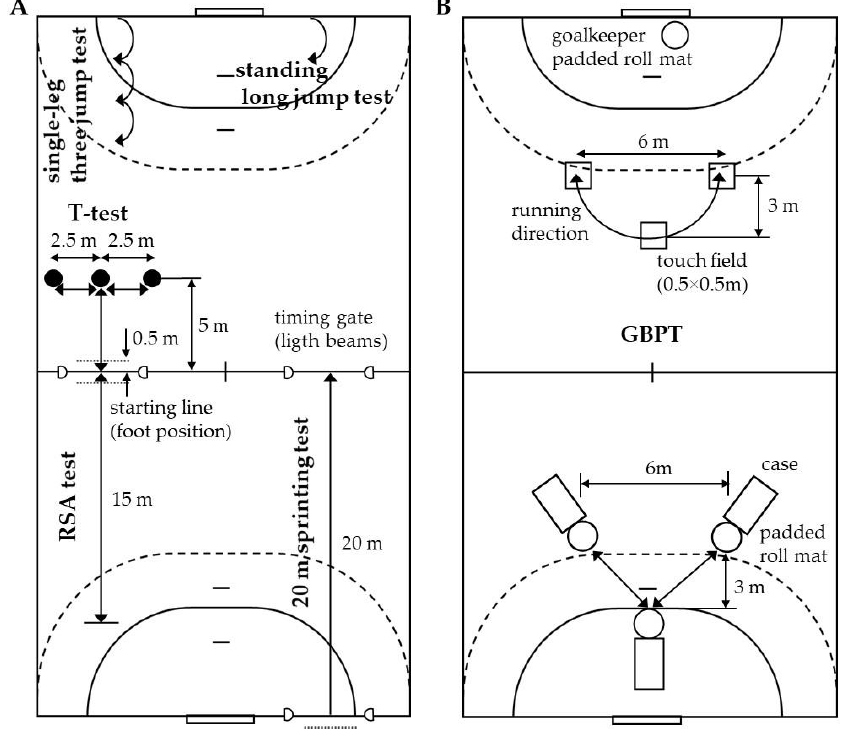
Figure 1. Schematic diagram of the ( A ) 20 m sprinting test, the modified t -test, the repeated sprint ability (RSA) test, the single-leg three and standing long jump test, as well as the ( B ) team hand game-based performance test (GBPT).